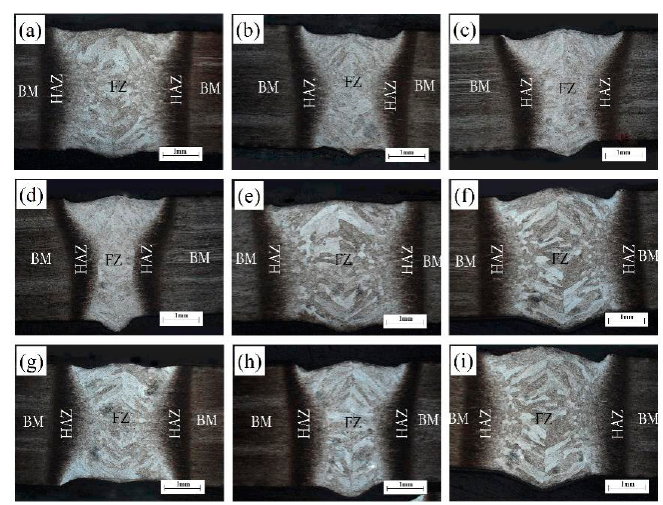
Figure 4. Optical micrographs of cross sections of as the laser-welded TC31 joints: ( a ‒ i ) represent W1 to W9 samples.